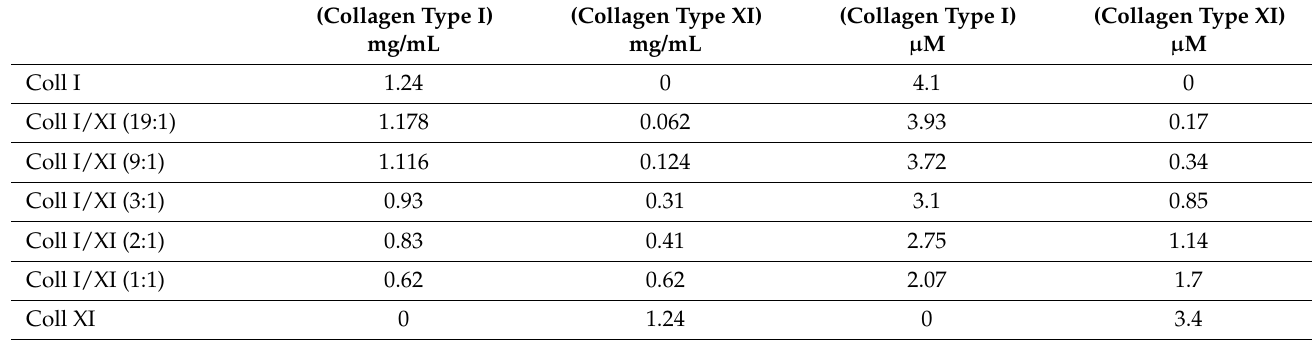
Table 2. Concentration of collagens in fibrillar collagen coating. The indicated ratios are for collagen type I: collagen type XI. The final collagen concentration is 1.24